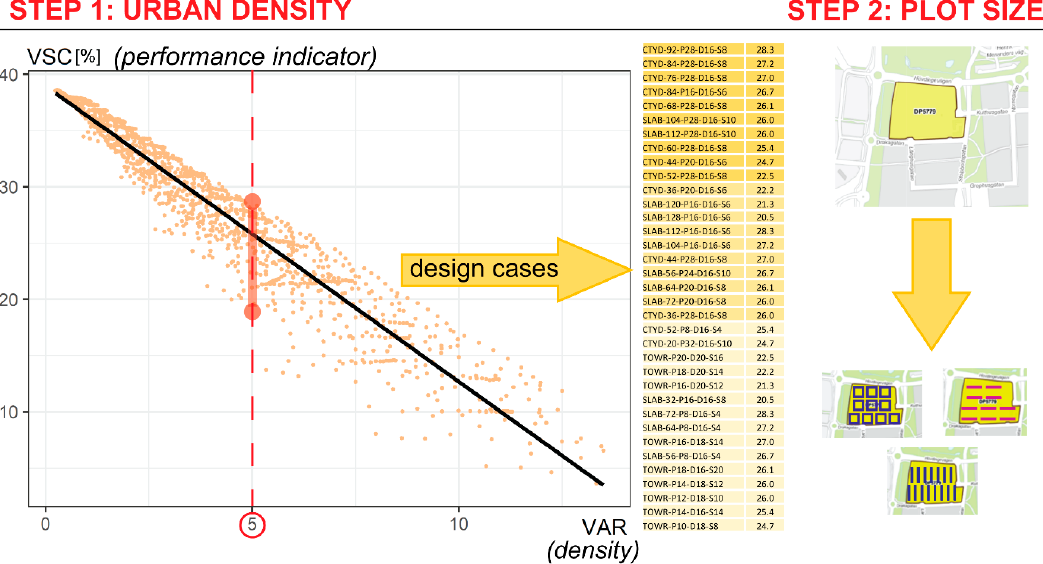
Figure 24. A suggestion for using the metric datasets in solar assessment of neighbourhood design in urban planning. In this example, the objective is daylighting of facades. Assuming target density and using the plot as an input, urban planners get suggestions for the best design options.